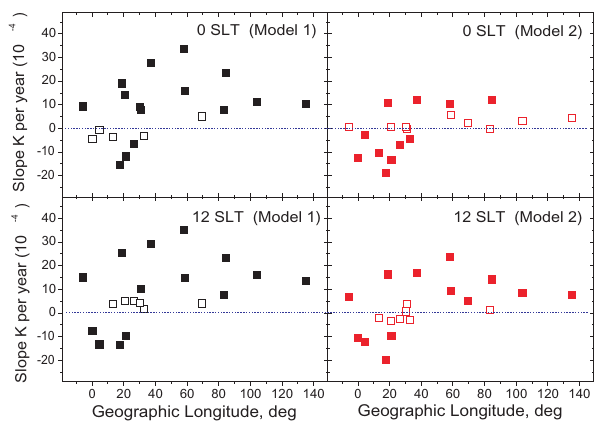
Fig. 4. Same as Fig. 3 but for the dependence on geographic longi- tude. Note some longitudinal effect with negative trends at western European